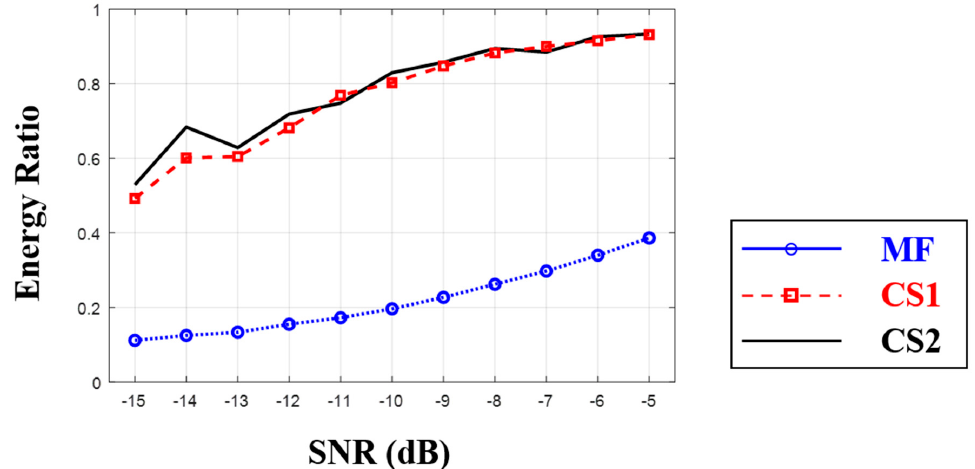
Figure 9. Energy ratios from three di ff erent schemes: Matched filter (MF, dotted line), repeated usage of compressive sensing (CS) along multiple measurements (CS1, dash line), and expended CS for multiple measurements (CS2, solid line). While the MF result increases with the increment of signal-to-noise ratio (SNR), it is much less than 1, owing to overall residing peaks by noise. Two CS-based schemes show similar performance for the simple environment having a single arrival. However, expended CS for multiple measurements is better at most SNRs (in particular, at low SNRs). Both CS results approach to one since their estimates are more concentrated around true arrival with the increment of SNR.